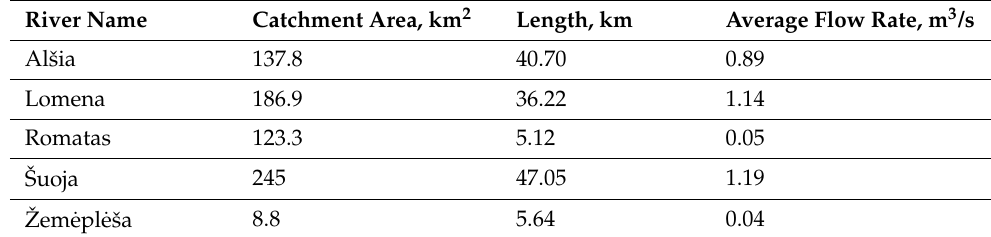
Table 1. Hydrological characteristics of investigated rivers.